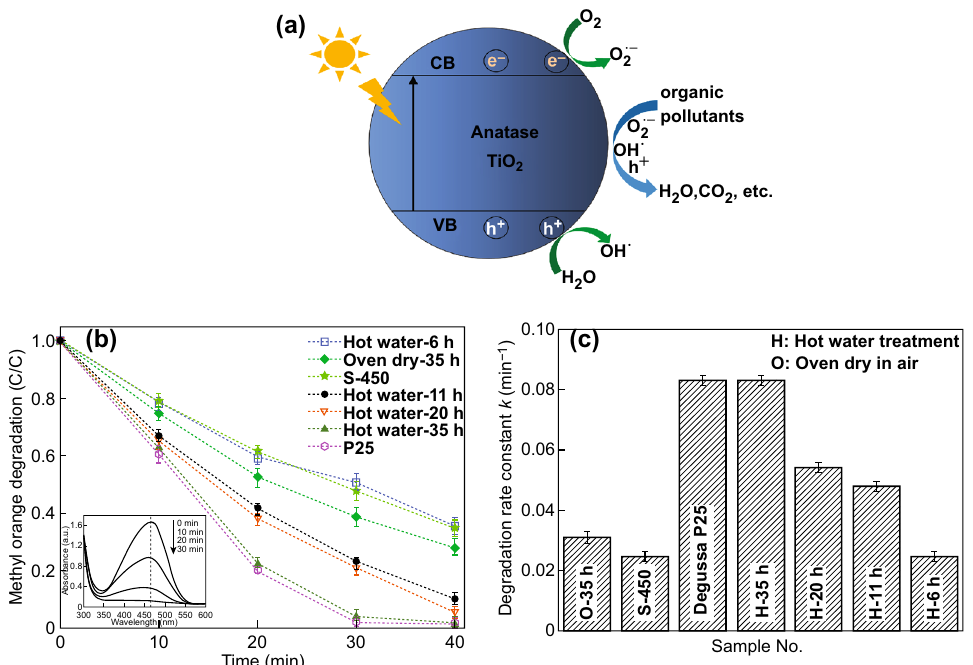
Fig. 13 a Schematic illustration of the reaction process for degrading pollutants by TiO 2 under irradiation. b Photocatalytic degradation kinetics of the MO (methyl orange) aqueous solution and c the degradation rate constant by using the TiO 2 NT-powders obtained by water immersion with different treatment duration times at 92 (cid:3) C (the inset of b shows the MO degradation processing with the TiO 2 NT-powders after hot water treatment at 92 (cid:3) C for 35 h as photocatalyst, and S-450 refers to the sample sintered at 450 (cid:3) C for 3 h) [39]. Copyright (cid:2) 2011 American Chemical Society. (Color figure